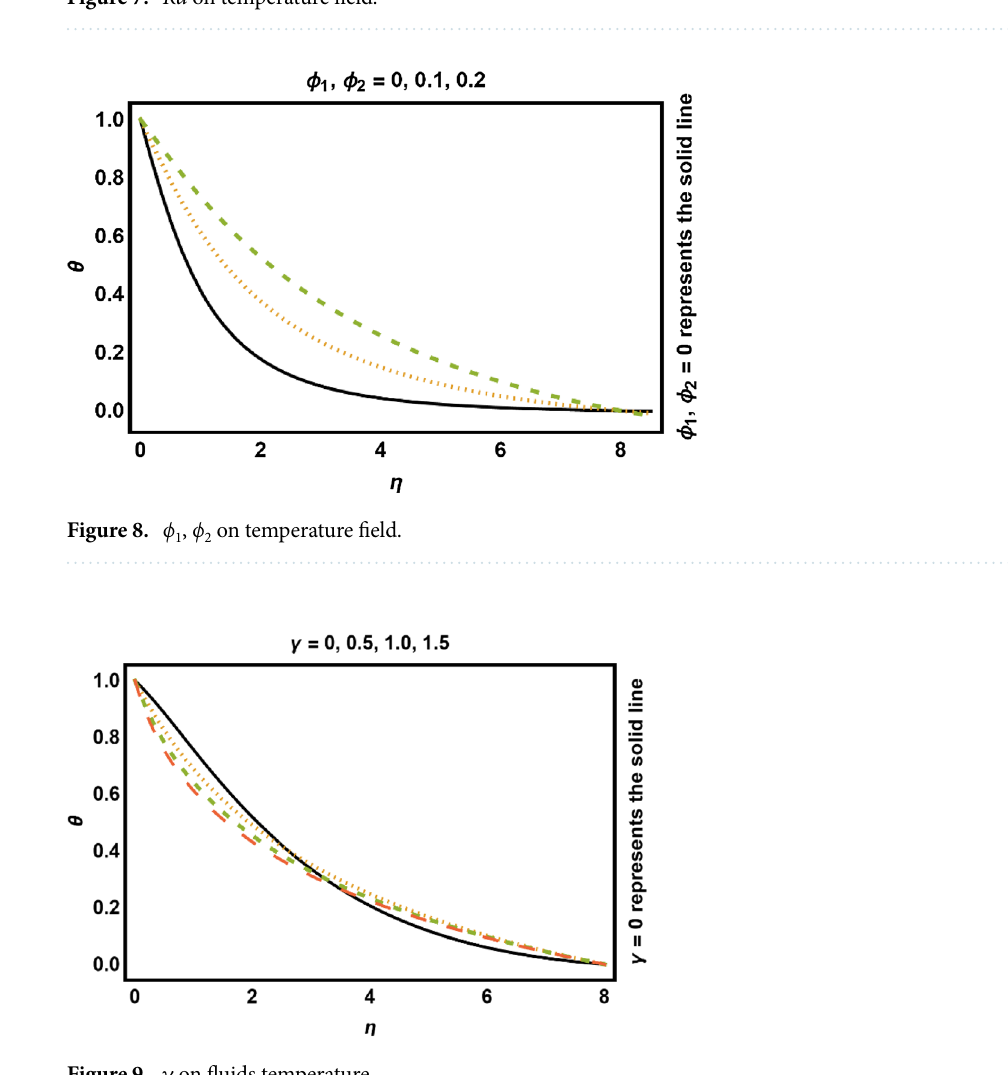
Figure 7. Rd on temperature field.